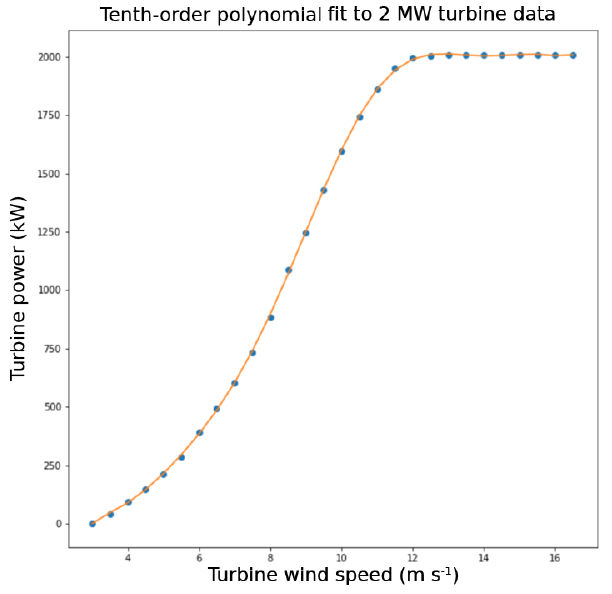
Figure 2. Tenth-order polynomial fit (orange line) to 2MW Vestas turbine data from Vestas